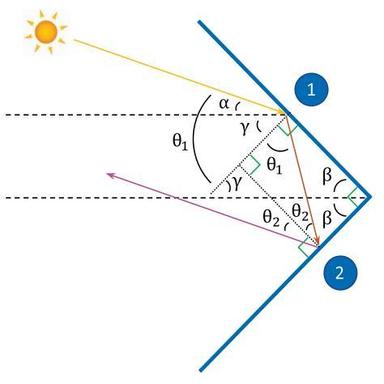
Angles of incidence and reflectance at faces of a vertical symmetric twosurface retroreflector (isosceles right triangle formed by orthogonal faces 1 and 2 and their undrawn vertical hypotenuse; = 45°).